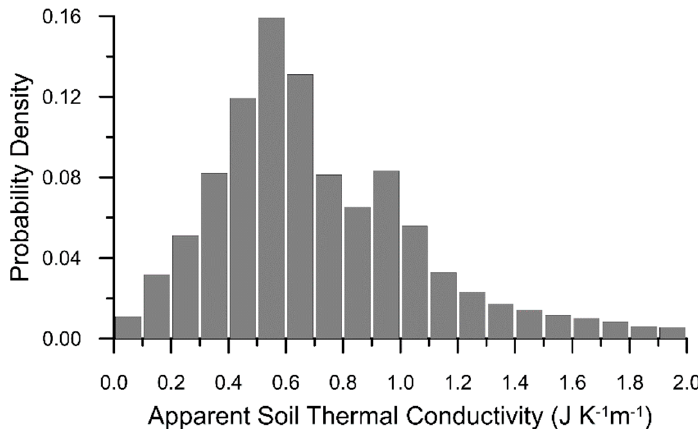
Figure 12. Probability density of soil Apparent Thermal Conductivity at CDGr.